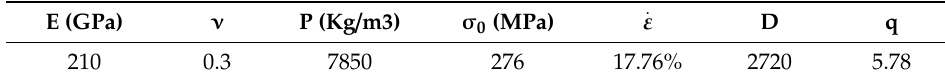
Table 1. Material parameters of stainless steel.